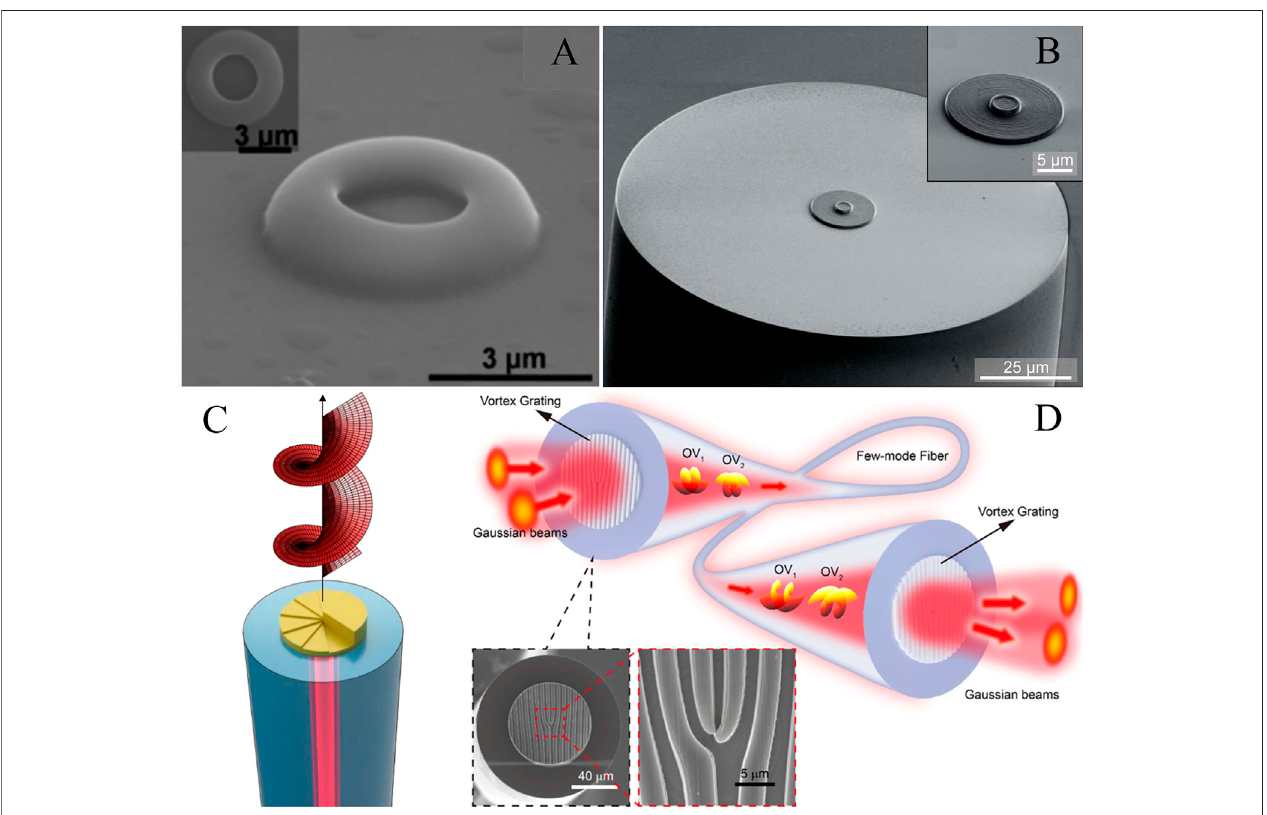
FIGURE2| Optical fi berintegratedpolymerphaseplatesprintedbyTPP. (A) RingshapedphasemaskprintedontheSMFforef fi cientcoupling(Cojocetal.,2010; Liberaleetal.,2010). (B) Diffractivephaseplatefabricatedbymeansofring-by-ringprintedontheSMFforspatialintensityshaping(Gissibletal.,2016a). (C) Spiralphase platewith10discretestepsprintedontheSMFfortheef fi cientconversionofopticalvortexbeamscarryingOAM(Weberetal.,2017). (D) Vortexgratingasintegrated(de) multiplexer attached onto the facets of a few-mode fi ber (Xie et al.,